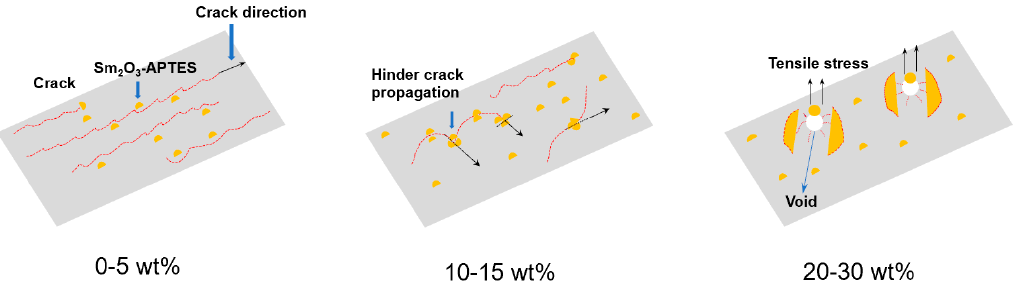
Figure 11. Mechanism diagram of Sm 2 O 3 -APTES improving mechanical properties of composites.